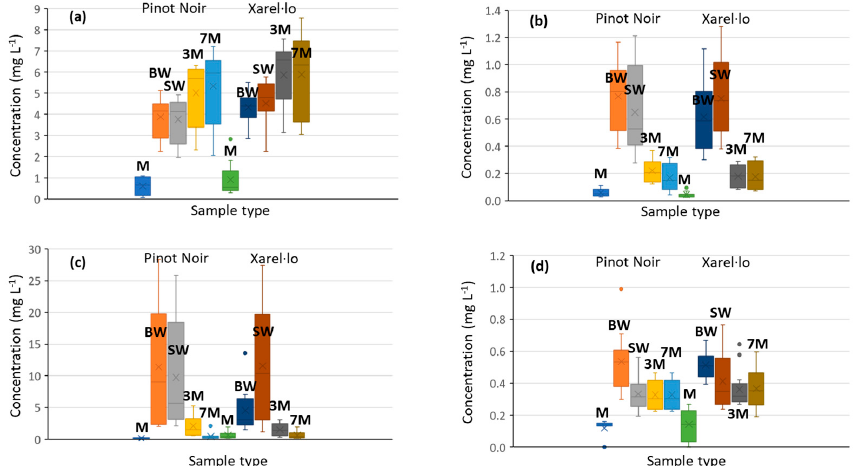
Figure 1. Boxplots with the evolution of the content of biogenic amines according to the sample type for the Pinot Noir and Xarel ∙ lo varieties; ( a ) ethanolamine; ( b ) phenylethylamine; ( c ) putrescine; and ( d ) tryptamine. Sample assignation: musts (M), base wines (BW), stabilized wines (SW), sparkling